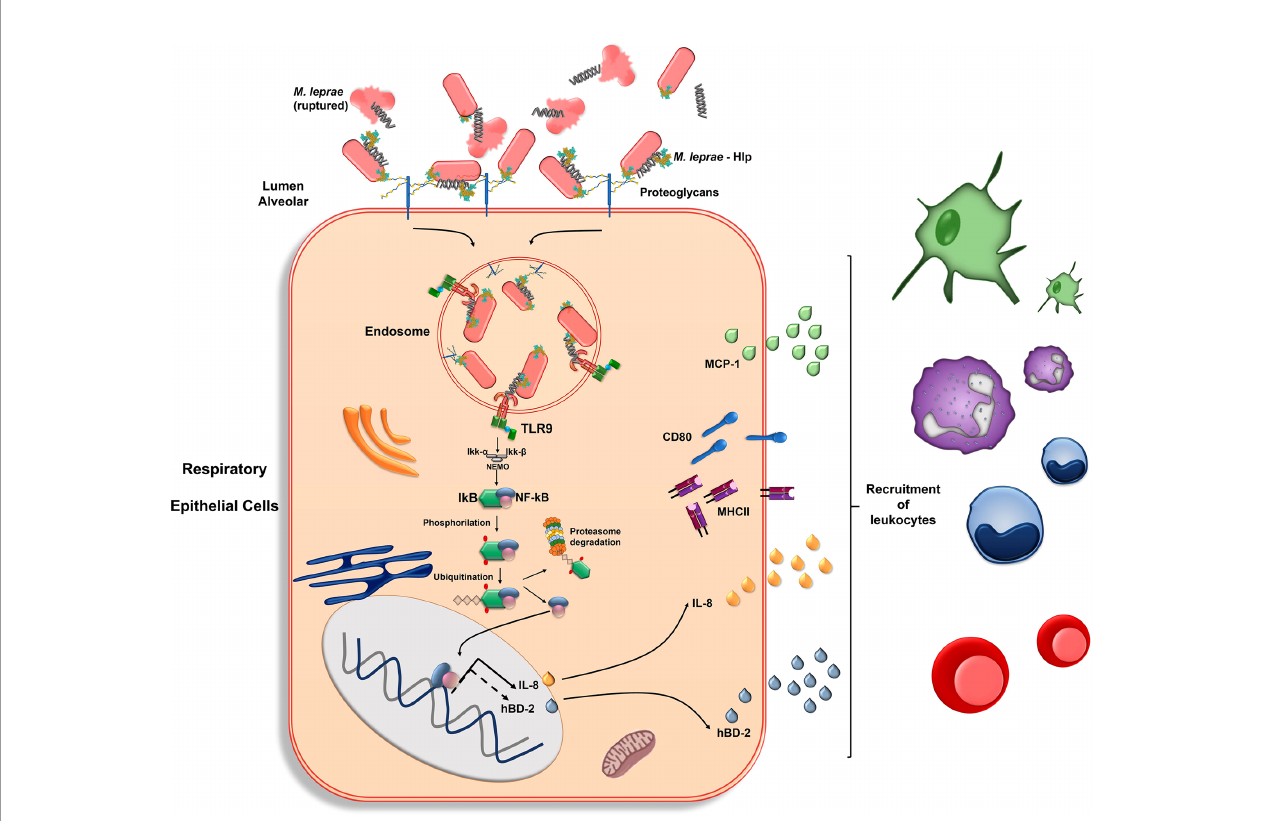
FIGURE 6 | Representative model of M. leprae- respiratory epithelial cell interaction with emphasis on the role of bacterial DNA-Hlp complex recognition in cellular immune activation. DNA molecules, probably derived from the leakage of dead bacteria, bind to surface-exposed Hlp, allowing the deposition and accumulation of DNA-Hlp complexes on the surface of viable and dead bacilli. Hlp mediates the adhesion and internalization of M. leprae to respiratory epithelial cells via its (Hlp) capacity to bind extracellular matrix proteoglycans. In the endosome, the DNA-Hlp complex interacts with the TLR-9, leading to activation and nuclear translocation of the NF- k B transcription factor with subsequent induction of IL-8. The h b D-2 is also induced, possibly via NF- k B (90 – 92) (dotted arrow). MCP-1 is also produced in response to M. leprae , however, in a NF- k B-independent manner. M. leprae also induces the expression of MHC-II and co-stimulatory molecules like CD80. This immune activation mediates the recruitment of leukocytes to the infection site, represented by dendritic cells (green), neutrophils (lilac), monocytes (blue) and T cells (red), contributing to the generation of a protective adaptive immune